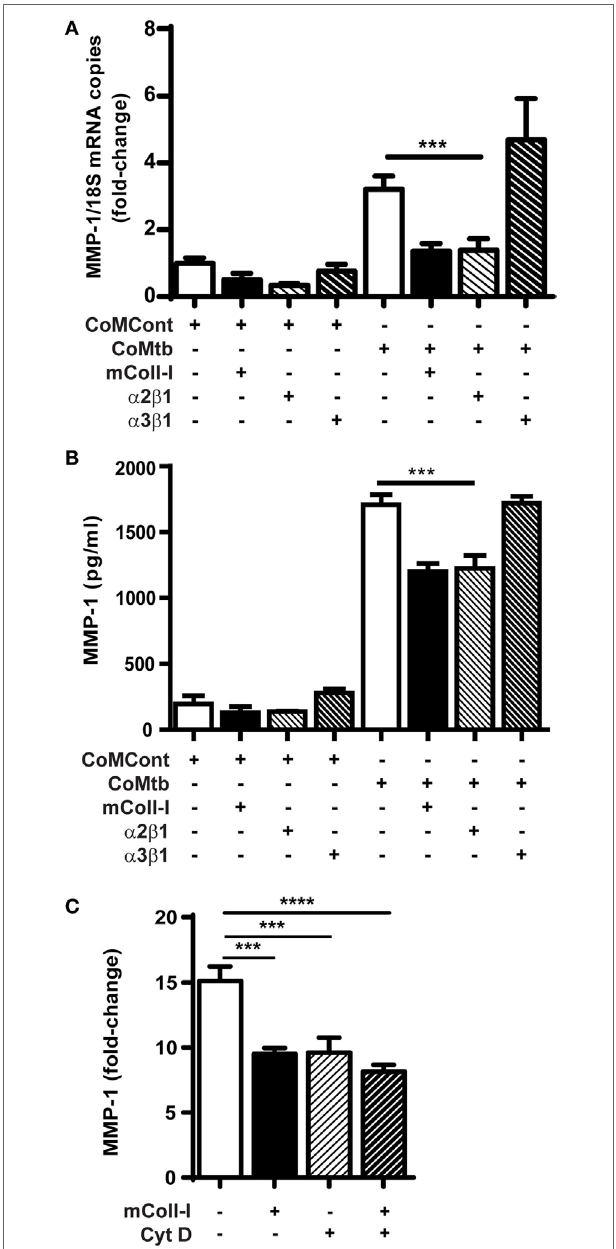
FigUre 2 | CoMtb-driven matrix metalloproteinase (MMP)-1 gene expression and secretion is regulated by integrin α 2 β 1 and actin cytoskeleton. Human bronchial epithelial cells (HBECs) were seeded in matrix type I collagen (mColl-I) or wells coated with anti-integrin antibodies and stimulated with CoMtb or control medium. (a) MMP-1 secretion from HBECs in the presence or absence of coated anti-integrin α 2 β 1 or anti- α 3 β 1 antibodies. (B) Fold-change in MMP-1 mRNA accumulation in the presence or absence of coated anti-integrin α 2 β 1 or anti- α 3 β 1 antibodies. MMP-1 mRNA copies were normalized to 18S mRNA and fold-change is relative to mean MMP-1 expression in control wells without extracellular matrix. (c) MMP-1 from HBECs pre-incubated for 2 h with 4 µg/ml cytochalasin D before stimulation with CoMtb for 24 h. This figure shows fold-change relative to mean MMP-1 secretion by the respective controls in the absence of CoMtb. Plots show mean and SD of assays performed in triplicate, which were replicated on three occasions. p -Values were obtained with one-way ANOVA with Tukey’s range test. *** p < 0.001; **** p <